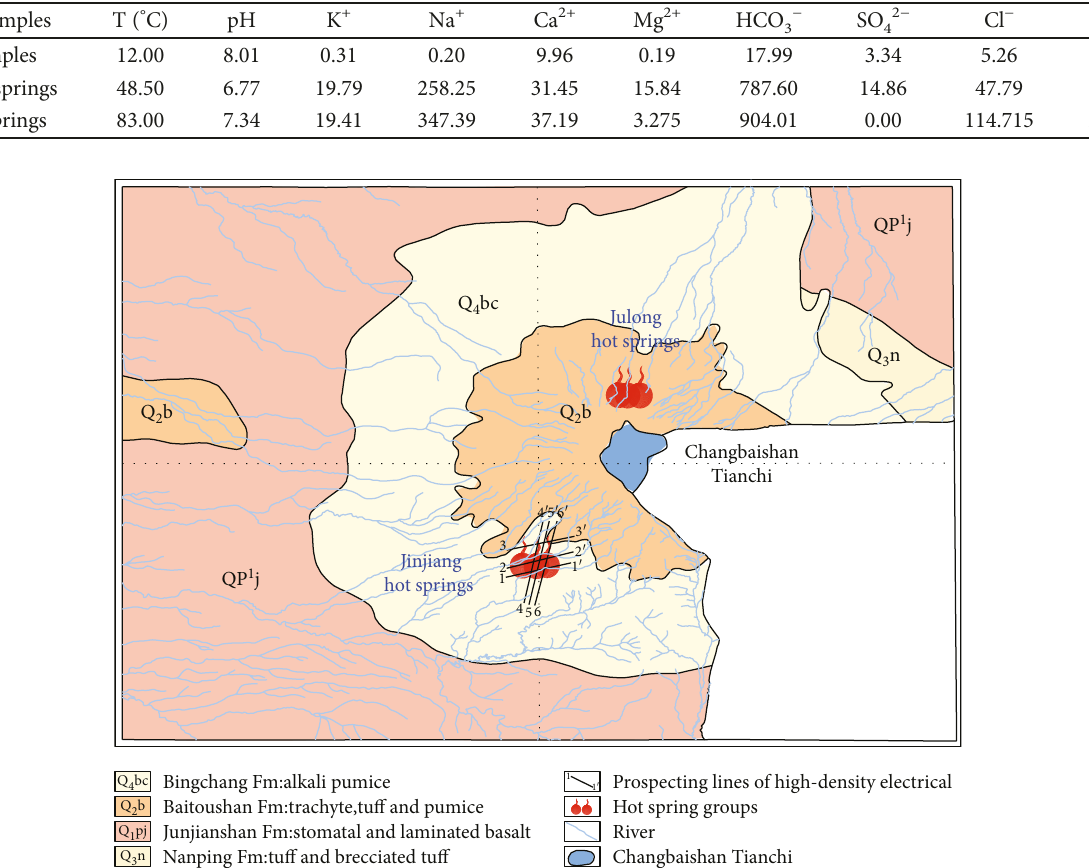
Figure 3: Arrangement diagram of the prospecting lines of the high-density electrical